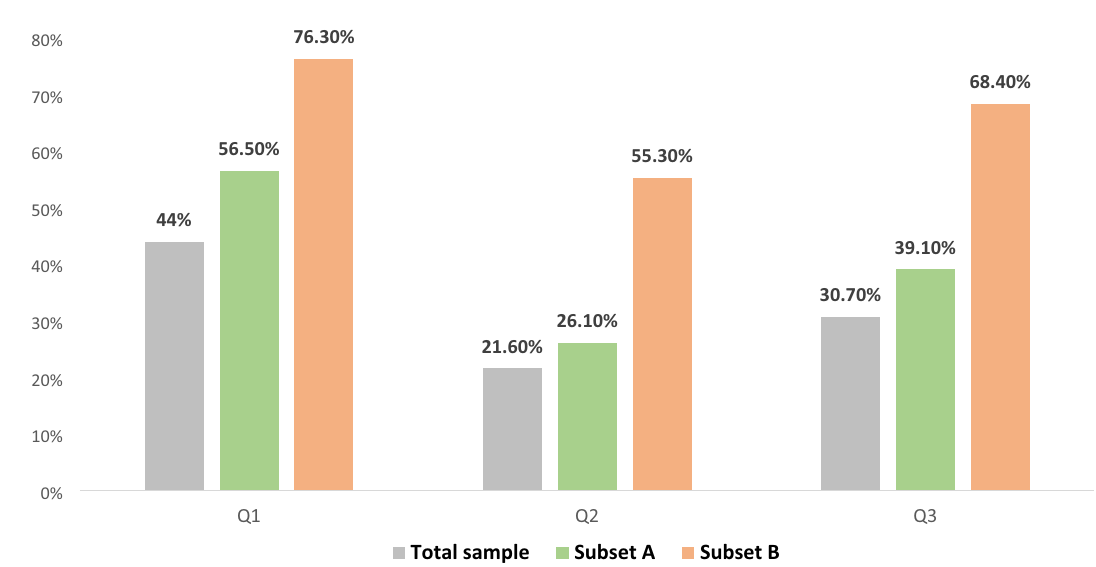
Figure 1. Clinical experience on conservative treatment of endometrial cancer for fertility preservation purposes. Question 1 (Q1): In your clinical work, have you ever been involved in the care of women with endometrial cancer who wished fertility preservation? Question 2 (Q2): In your clinical work, have you ever suggested or offered conservative treatment of endometrial cancer for fertility preservation? Question 3 (Q3): endometrial cancer care (N = 165). The chart illustrates positive answers.